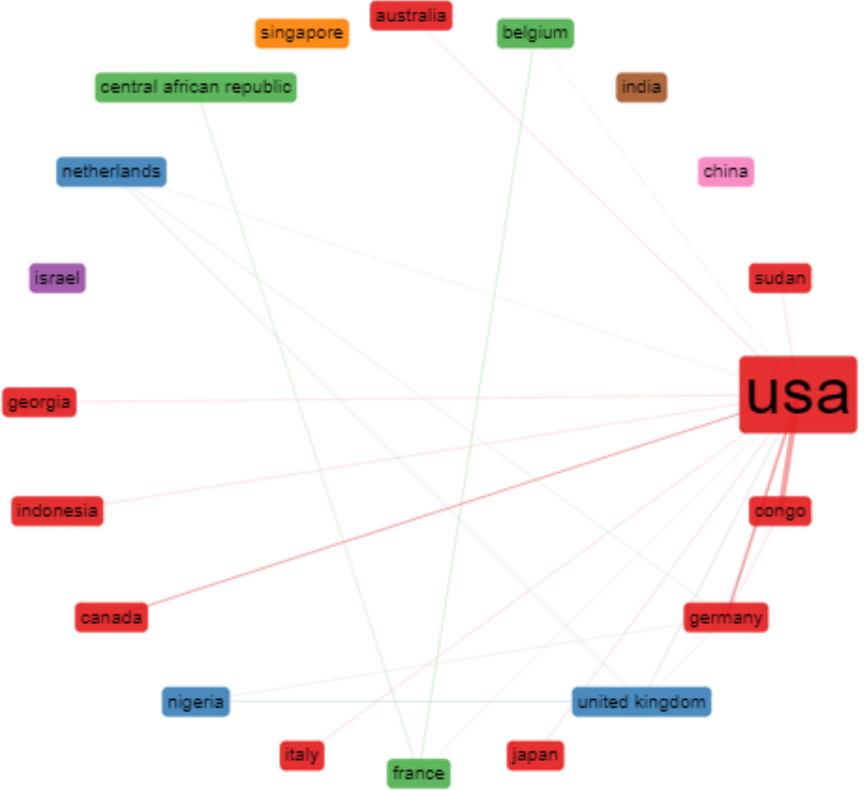
Figure 5. Visualization of international collaboration. Table 5. Countries with the highest total and average article citations.